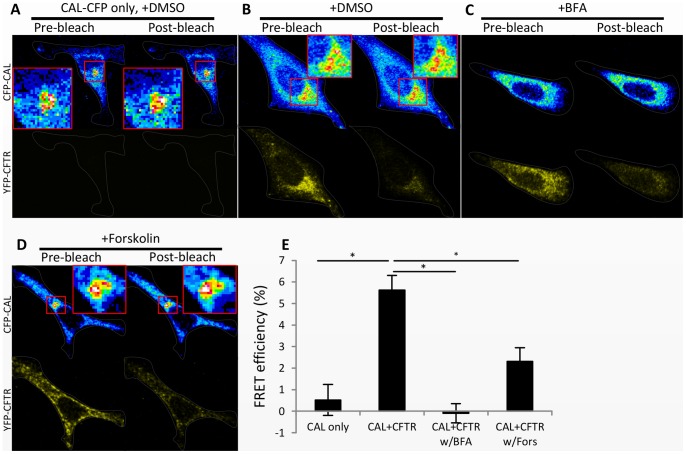
Disrupting the Golgi structure with brefeldin A and increasing the cell-surface expression of CFTR with forskolin diminish the FRET of CAL and CFTR.HeLa cells were transfected with CAL-CFP (0.5 µg) only (A) or with CAL-CFP (0.5 µg) and YFP-CFTR (1.5 µg) (B–D). DMSO (A, B), 10 µg/ml brefeldin A (BFA) (C), or 100 µM forskolin (D) was added at 37°C for 30 minutes. Images before (left columns) and after (right columns) photobleaching with a 514-nm laser are shown. CFP and YFP are pseudocolored with a 16-bit lookup table and yellow, respectively. Cell outlines are drawn with gray lines. (E) is the statistical analysis of the FRET efficiency of CAL and CFTR. The FRET efficiency of CAL and CFTR was reduced when BFA or forskolin was added. Results are means ±SE. (n = 44–68) *p<0.001.